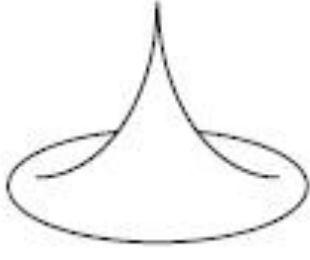
Figure 3. Principle of modeling of the area of influence of a core on its periphery, using Reilly’s